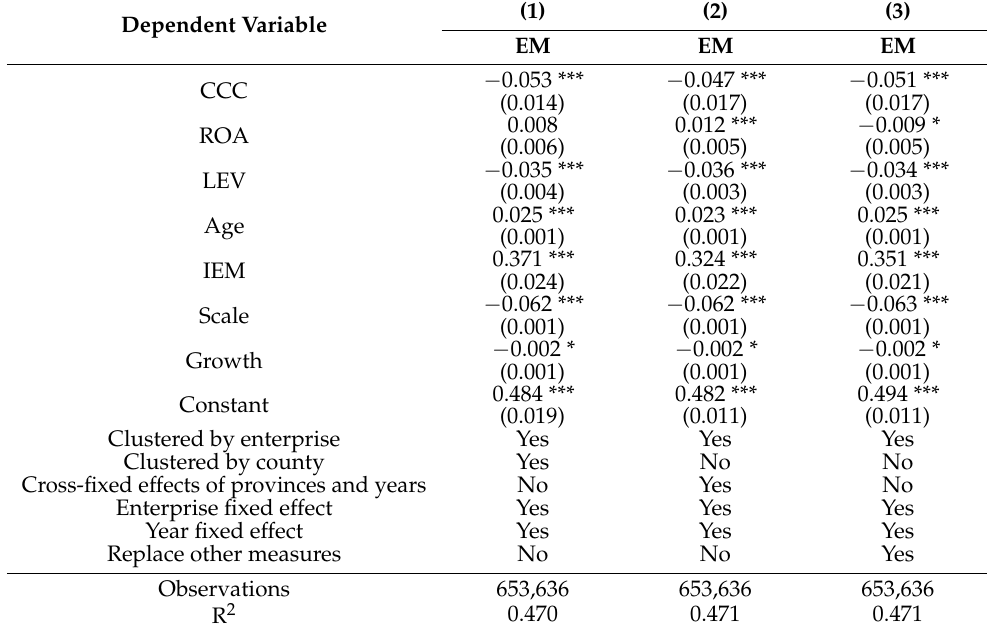
Table 3. The results of robustness